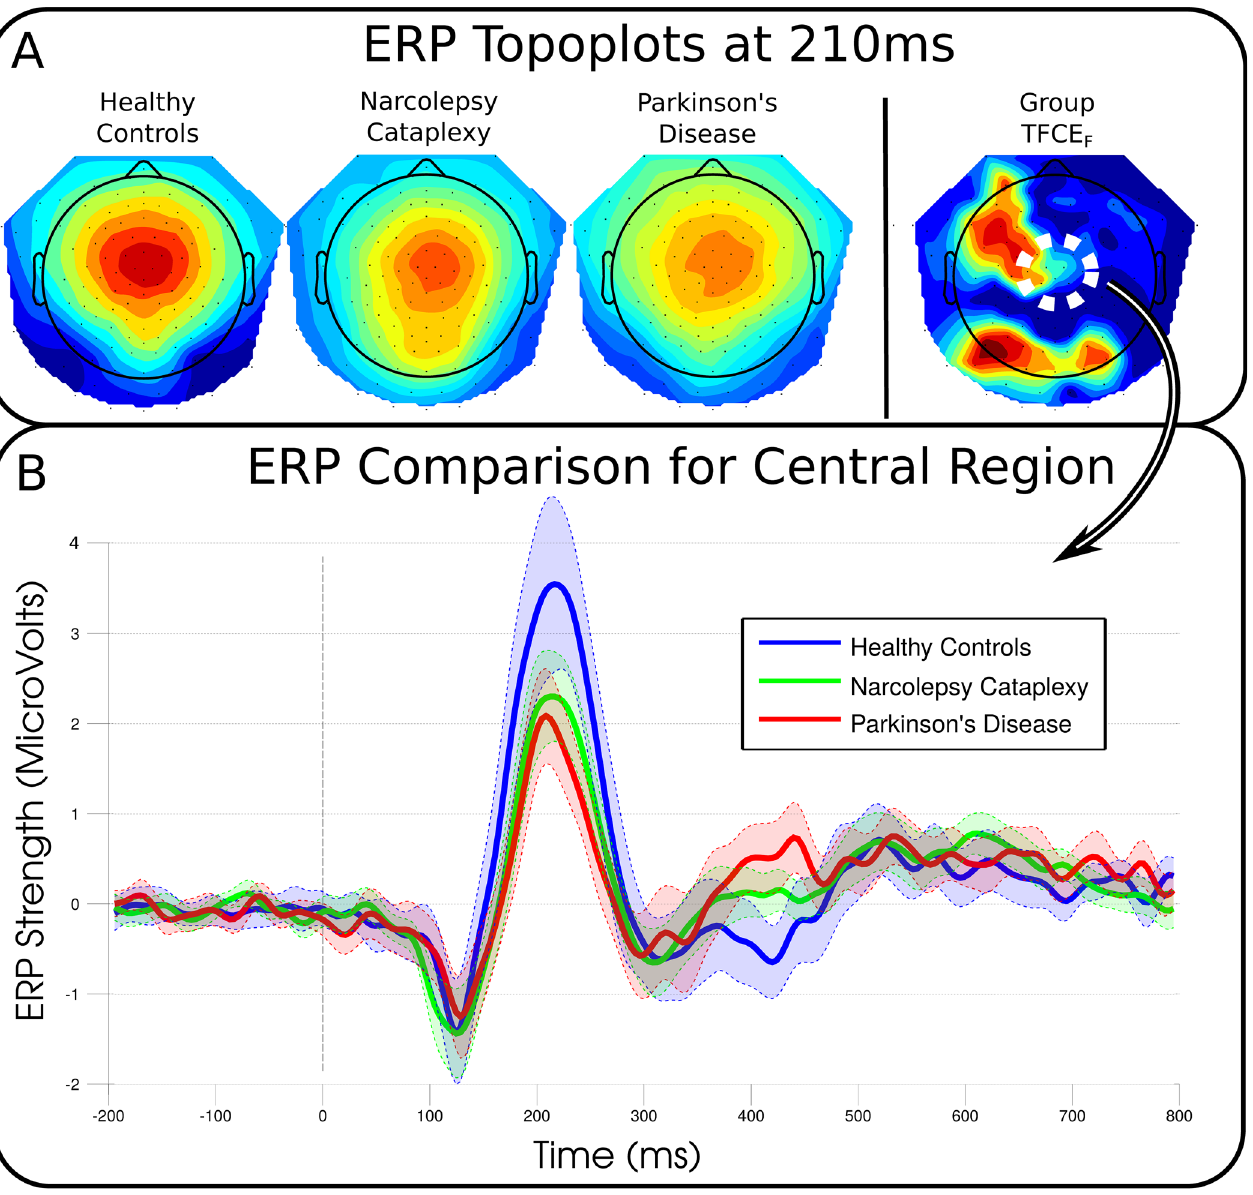
Fig 2. Cue-locked group topographies and event-related potentials over a central region of electrodes. No significant differences were found for either the group comparisons (12 participants in each group), or cue-type (valence or magnitude), conditions indicating participants ‘ and patients ‘ brain reactions were essentially the same for any cue. A, Topographies of the each group average and the resulting statistical comparison (blue to red as increasing significance). B, Event-related potentials recreated from the mean of 8 neighbouring channels in the central region of the scalp indicated by a dashed white circle in the group topoplot (E6, E7, E13, E30, E105, E106, E112, E129). The differences in groups around 210 ms were not found to be significant (F 2,33 = 2.245, p = 0.94), but individual participants amplitudes' were predictive of the early feedback-locked